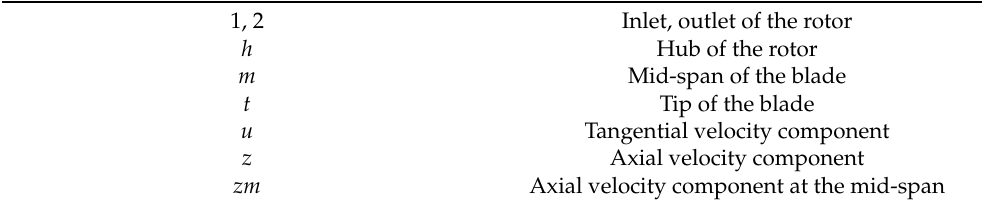
Table A2. Subscripts for